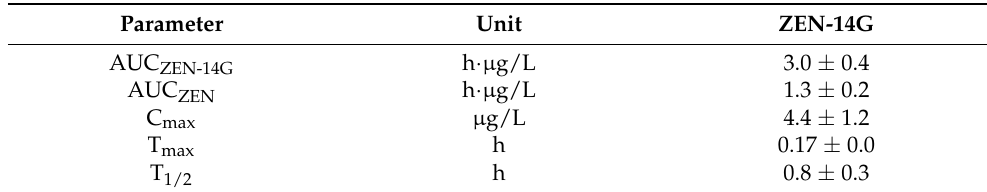
Figure 3. The plasma concentration vs. time profiles after the administration of zearalenone-14-glucoside (ZEN-14G) by gavage to rats (dose of 4 mg/kg body weight, n = 3). Table 4. Kinetic parameters after the administration of zearalenone-14-glucoside (ZEN-14G) by gavage to rats (dose of 4 mg/kg body weight, n = 3).